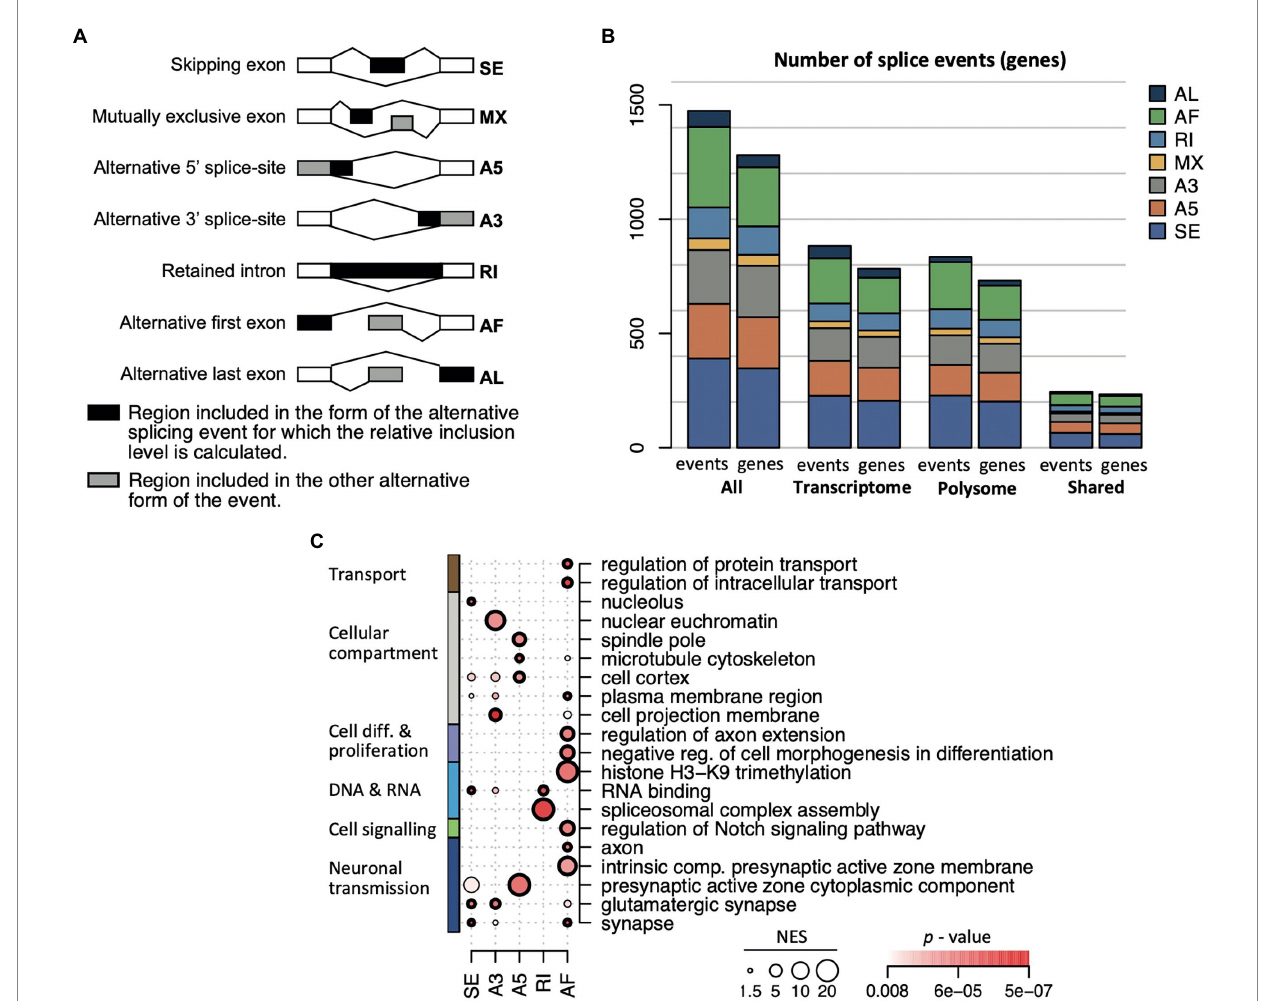
FIGURE 6 AS event types in the transcriptome and translatome. (A) Scheme of the seven different event types identified with the SUPPA2 analysis. The relative inclusion levels ( Ψ ) concern the region depicted in black; a gray area indicates alternative forms of the event. (B) Number of events and genes associated with each of the seven event types across the transcriptome and translatome (polysome). (C) Selection of 20 enriched themes overrepresented among genes displaying different splicing event types. The diameter of the circle is proportional to the NES score, the colormap refers to the p -value, circles in bold refer to FDR <